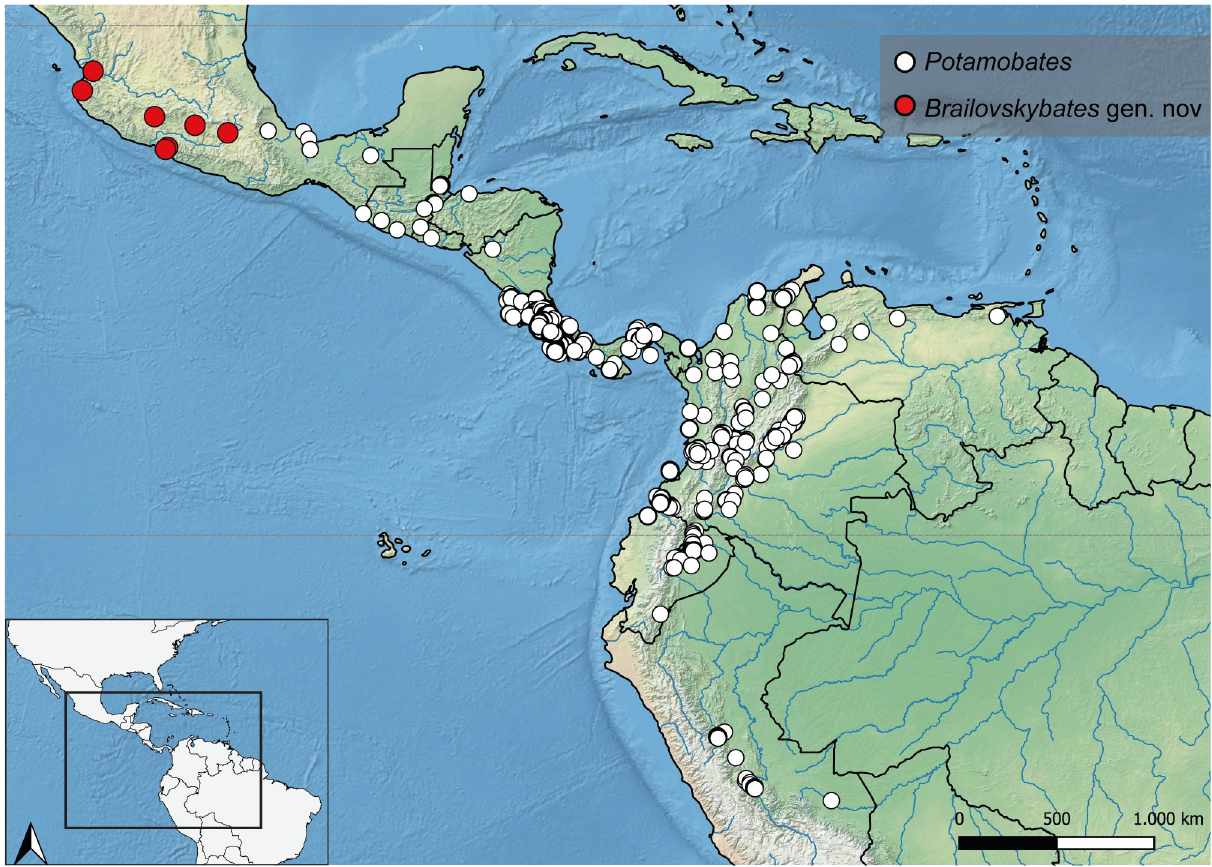
Fig 42. Map showing the geographical distribution of species of Brailovskybates new. genus and Potamobates . Spatial data from Natural Earth (http://www.naturalearthdata.com/). proctiger black. Female : abdominal laterotergites folded over mediotergites on segments IV–